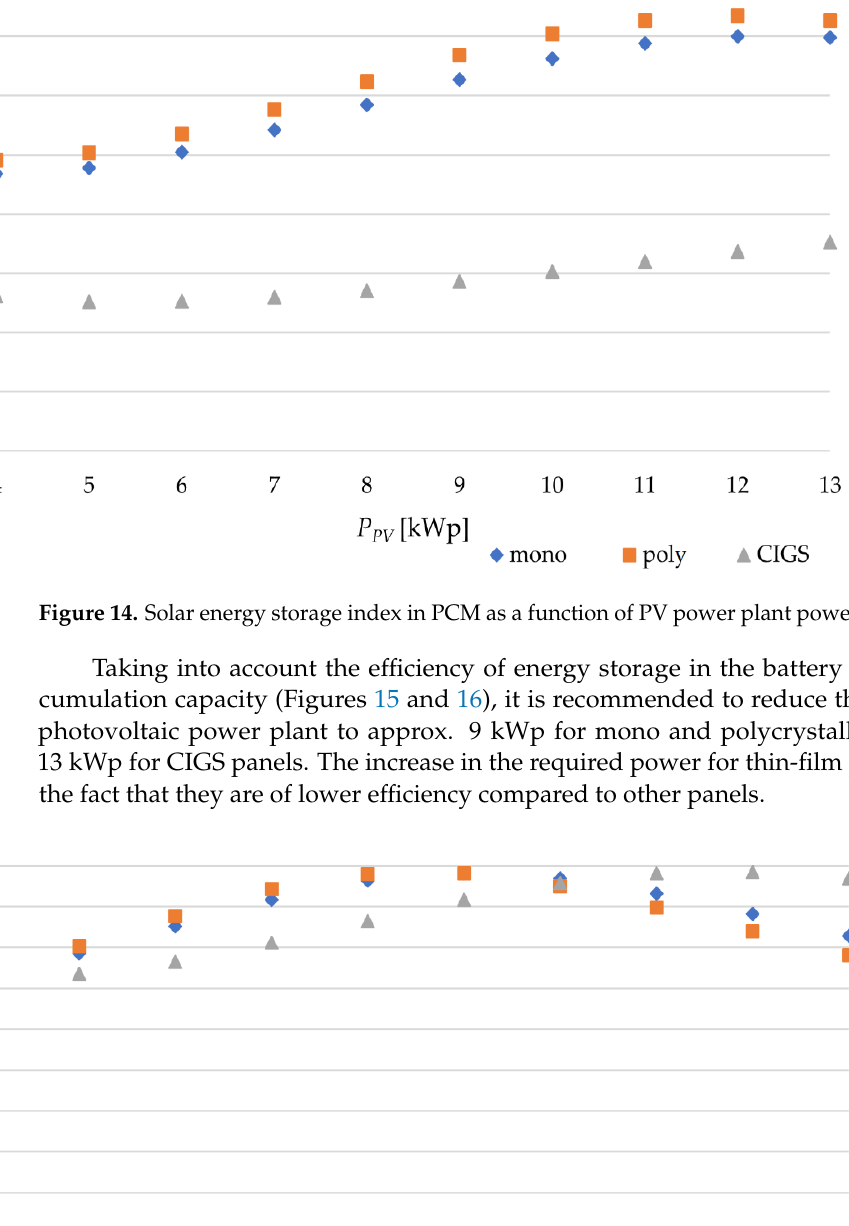
Figure 14. Solar energy storage index in PCM as a function of PV power plant power for cloudy days.